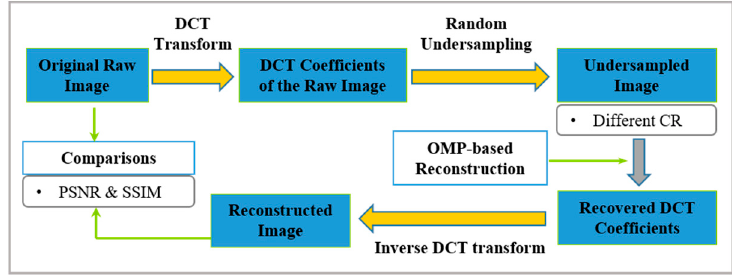
Figure 6. The sketch of the procedure used to reconstruct phased array images in frequency domain.